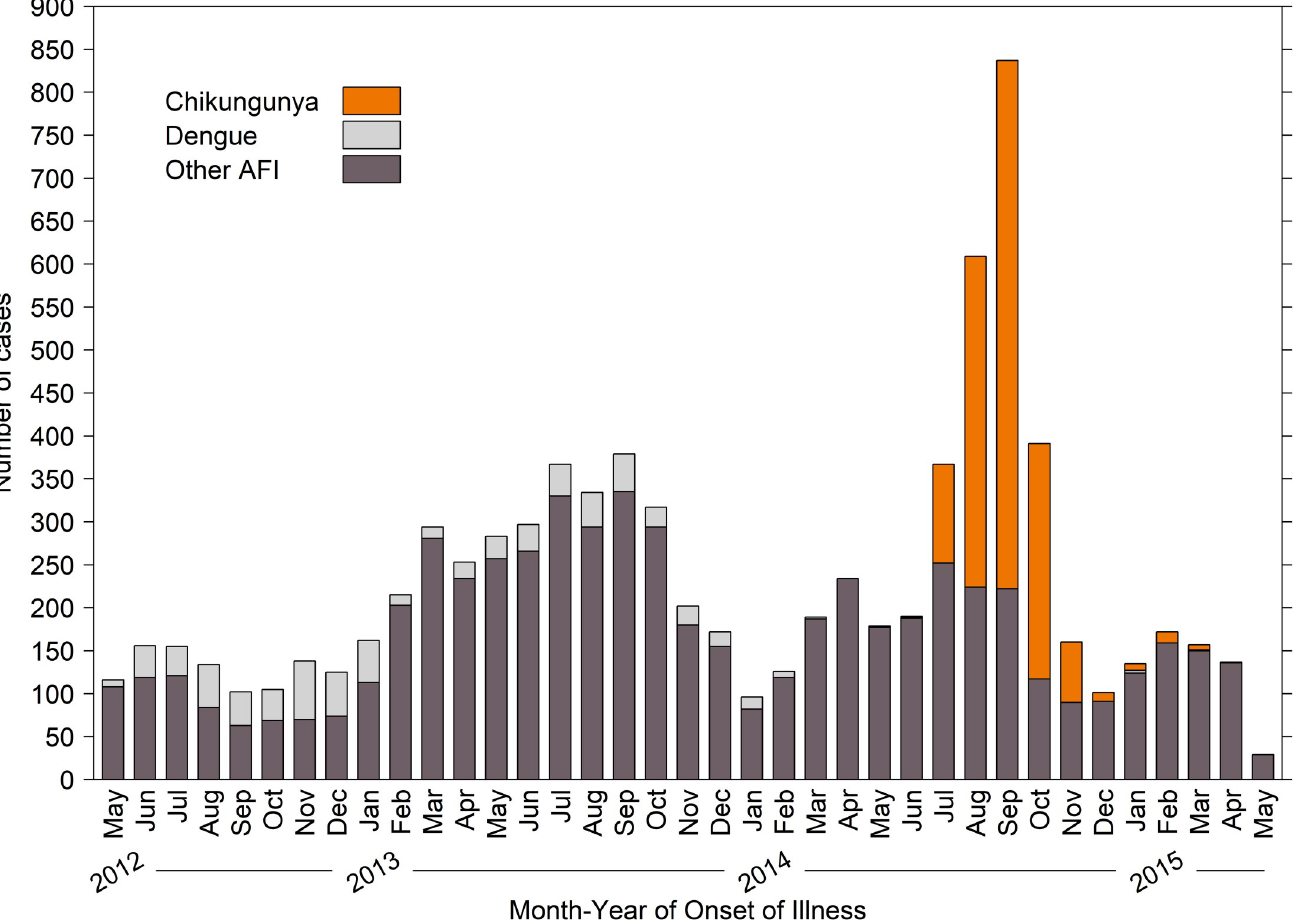
Fig 1. Number of acute febrile illness cases identified by month and year and pathogen detected, Acute Febrile Illness Study, May 7, 2012 –May 6, 2015, Puerto Rico.